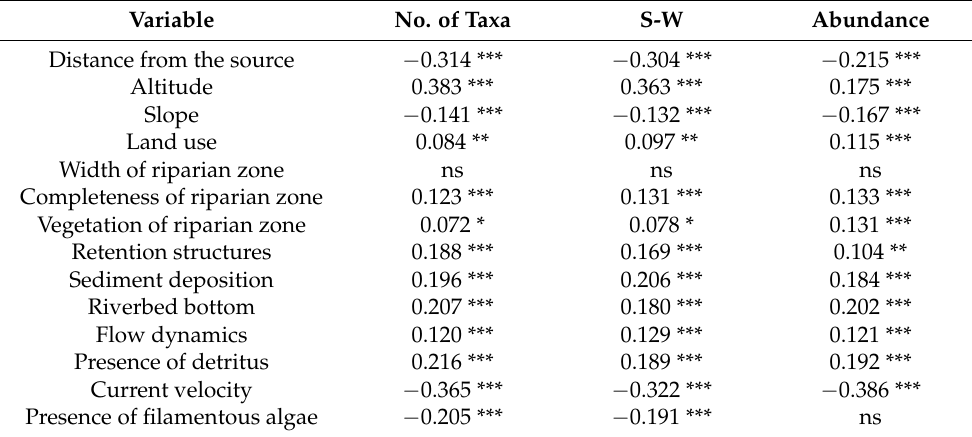
Table 1. Spearman correlation coefficients between diversity, abundance, and assessed environmental